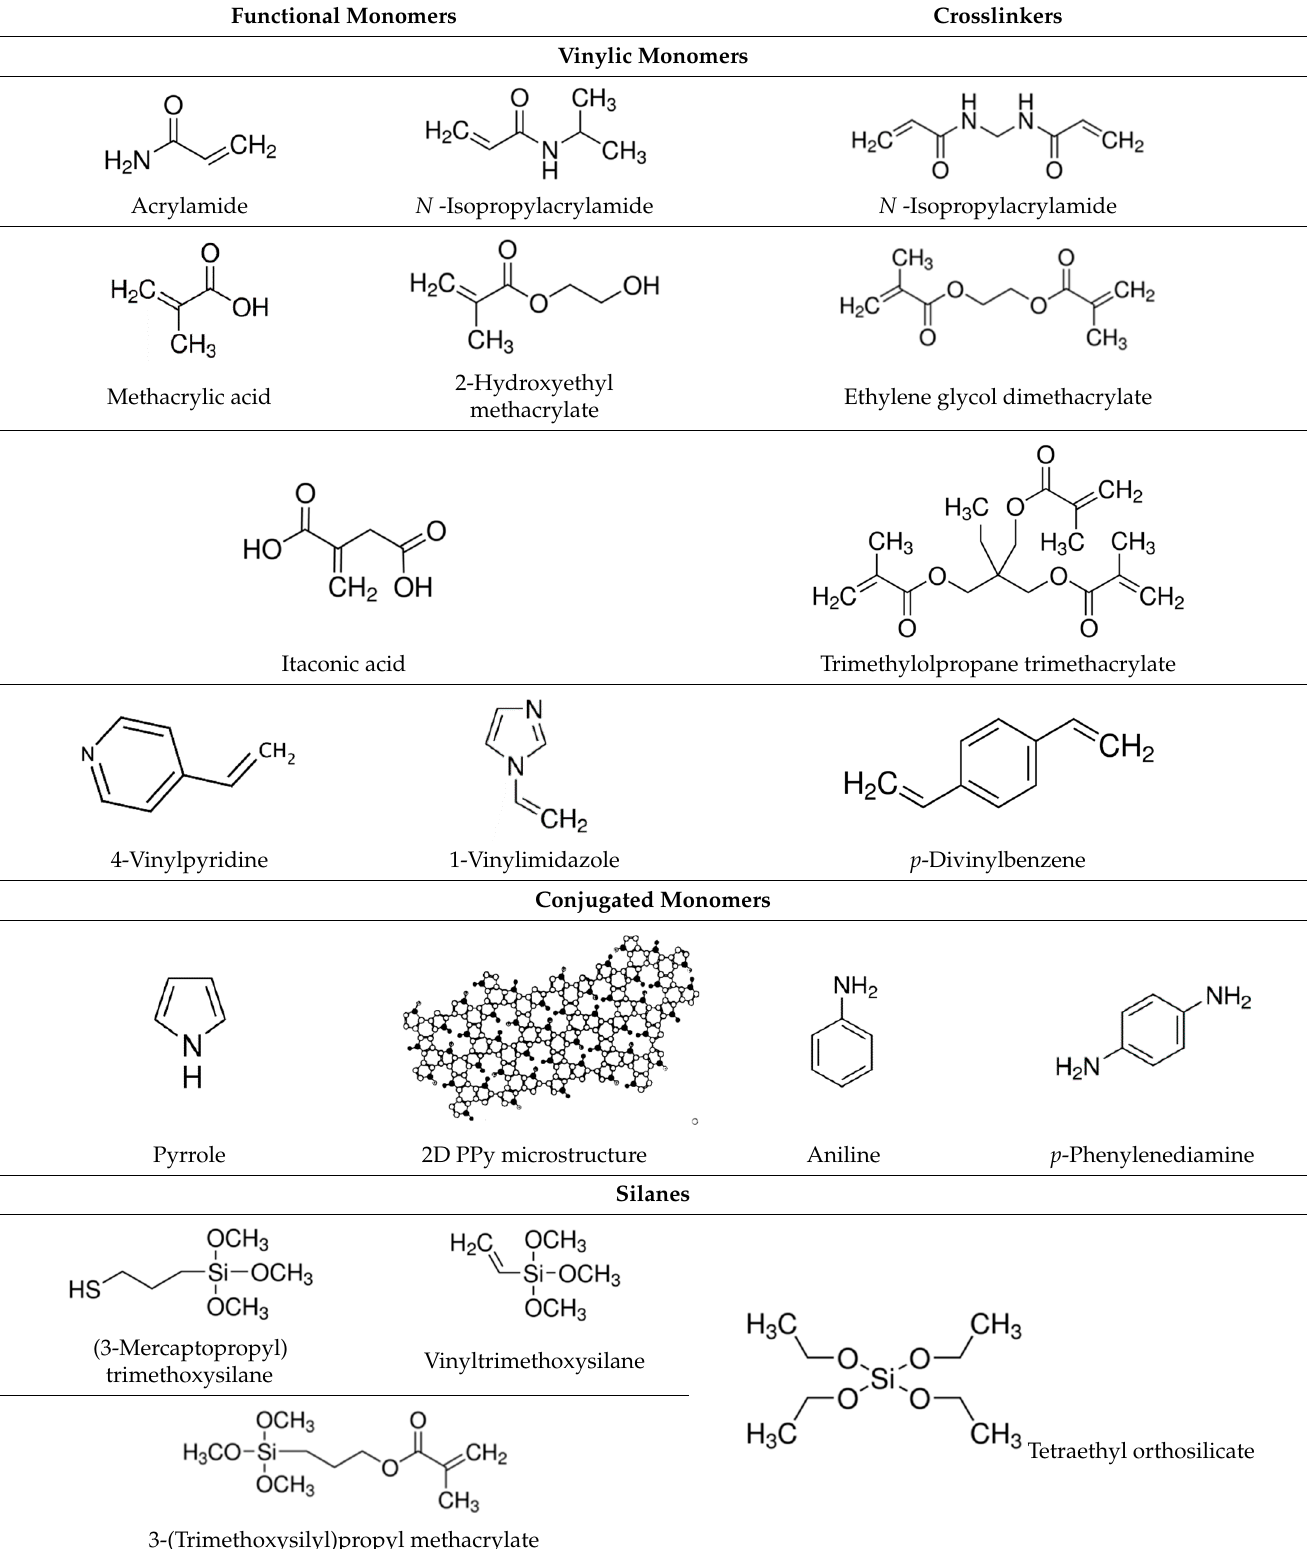
Table 2. Selected, commercially available monomers frequently employed for making MIPs. Pyrrole is displayed with its corresponding 2D microstructure.